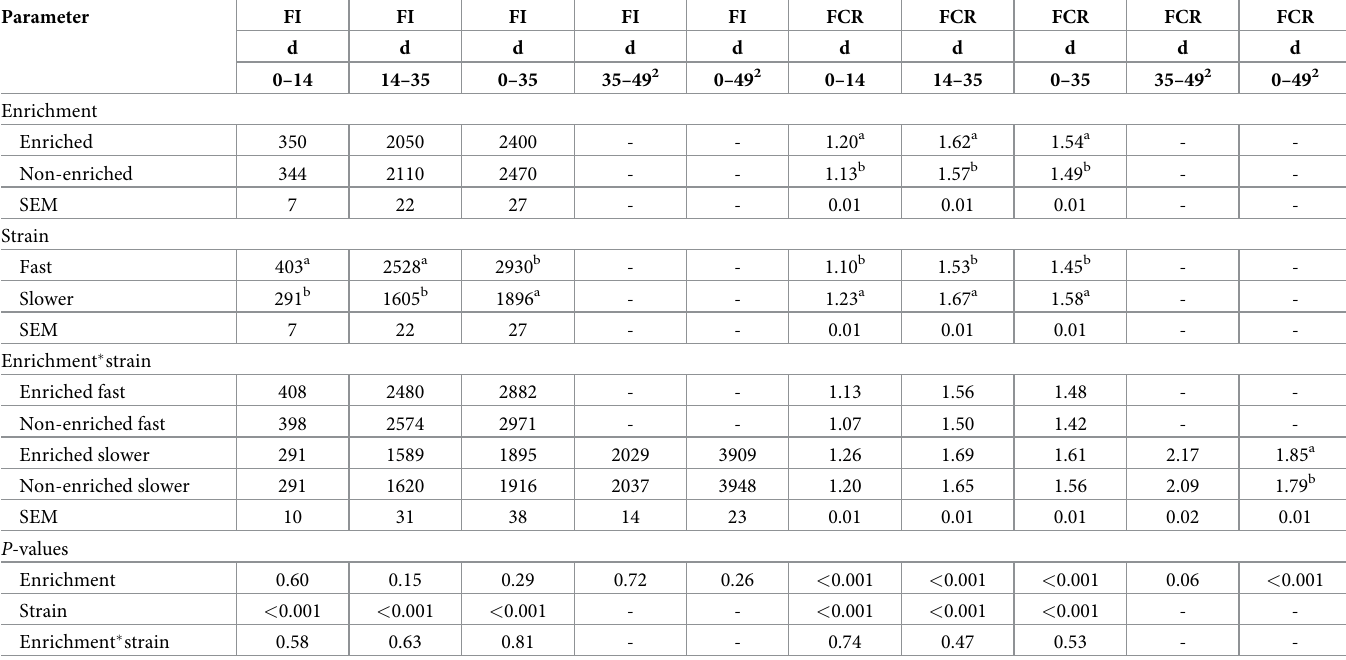
Table 2. Effects of pen enrichment (enriched or non-enriched), broiler strain (fast-growing ross 308 or slower-growing Hubbard JA 757) and their interaction on feed intake (FI; g per chicken) and feed conversion ratio (FCR = FI/BWG 1 ) of male broiler chickens in different phases of the rearing period (n = 7 pens per treat- ment, LSmeans ±